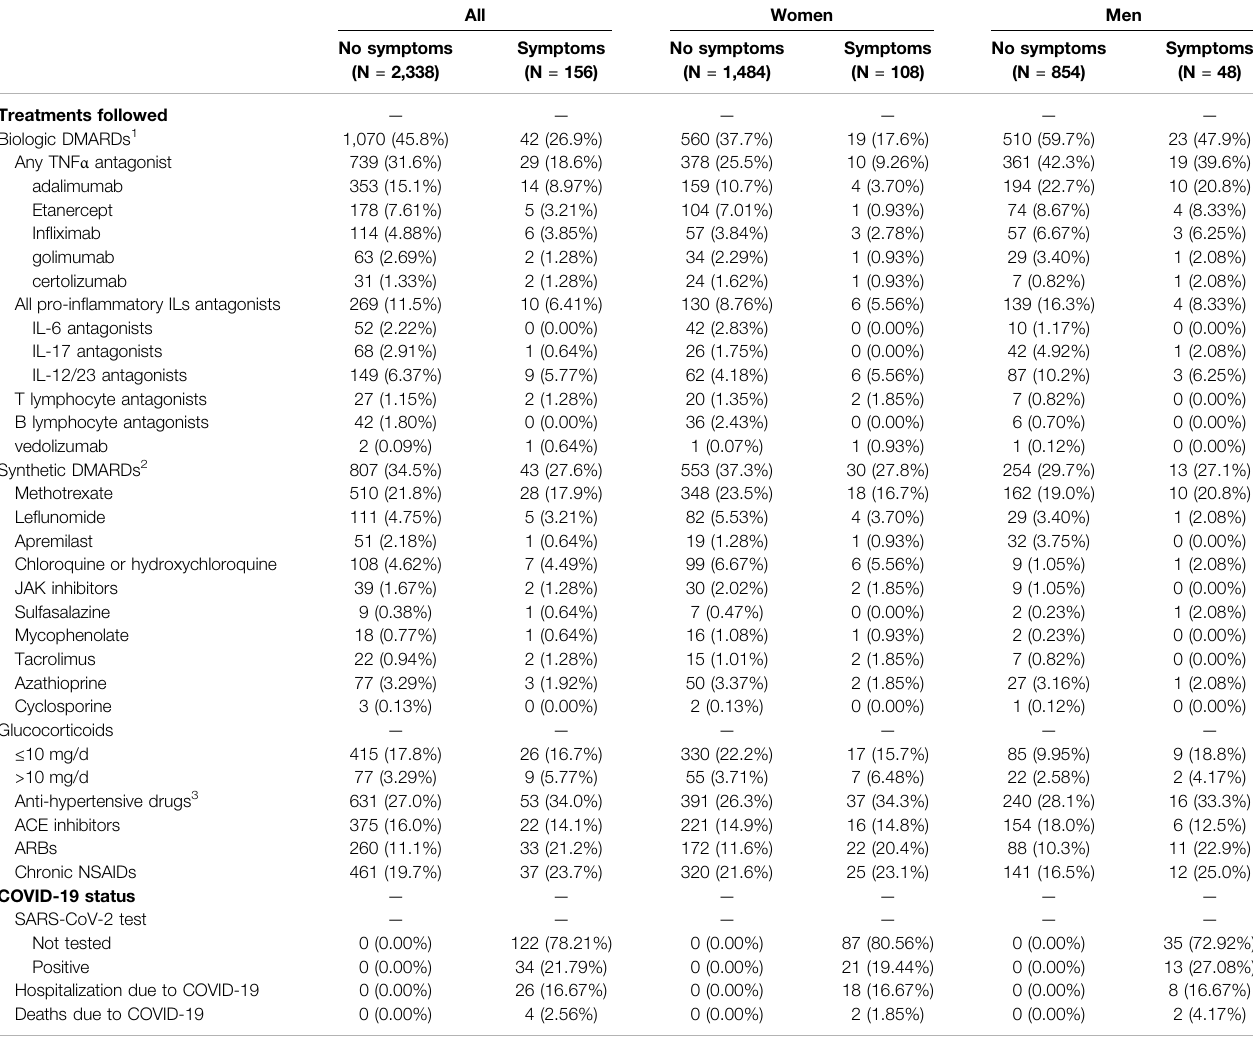
TABLE 4 | Distribution of COVID-19 across categories of study